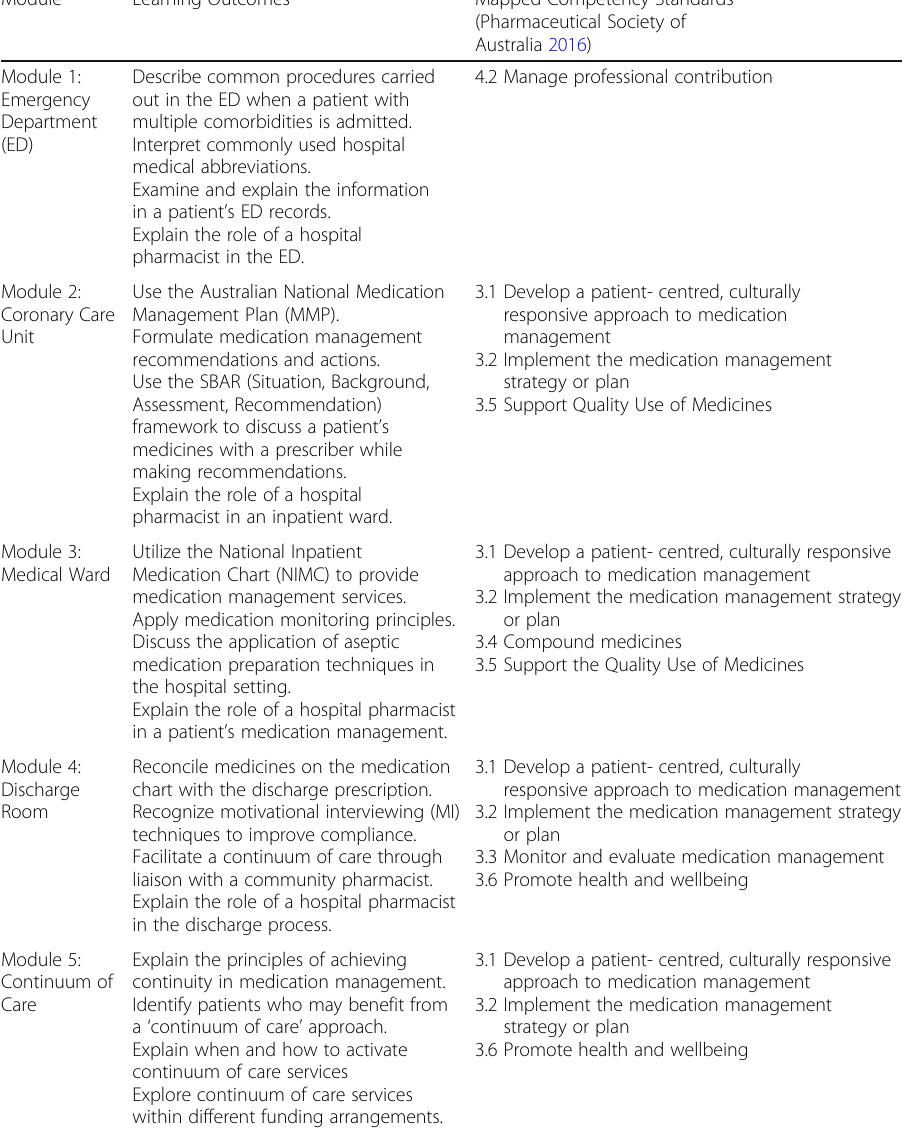
Table 1 Training package modules, learning outcomes and competencies addressed